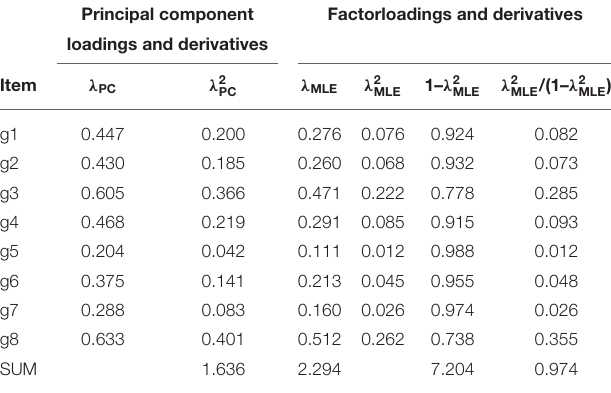
TABLE 3b | Principal component and factor loadings.